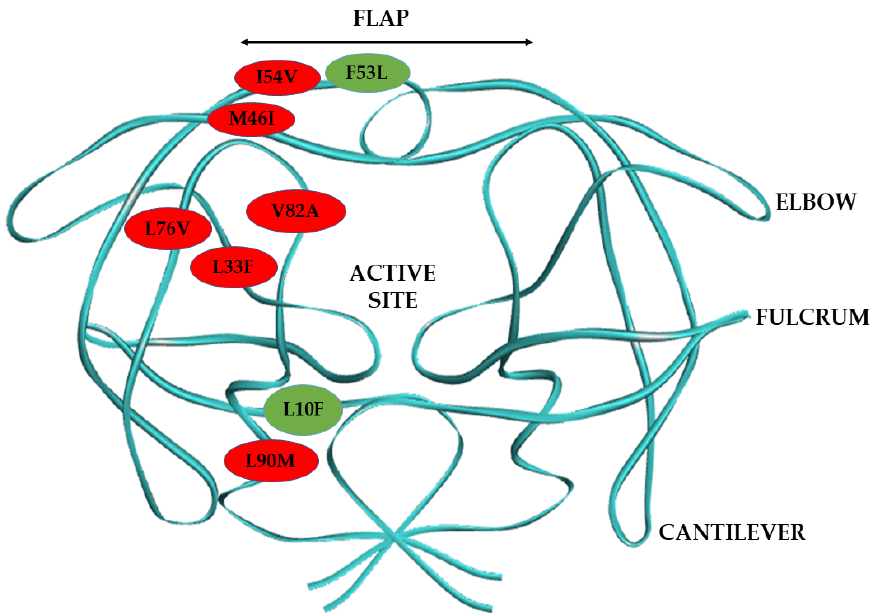
Figure 1. Diagrammatic representation of HIV-1 PR dimer structure and the mutations harbored by the mutant HIV-1 PR variants in this study. The major HIV-1 PR mutations are represented in red balls and the minor mutations in green balls.